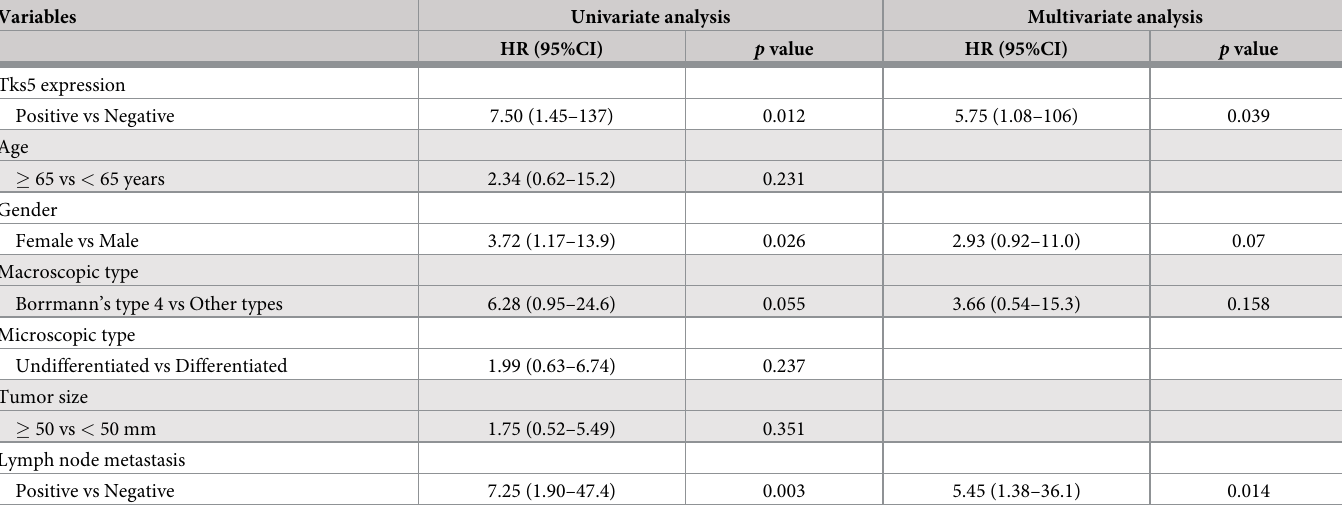
Table 2. Univariate and multivariate analysis for peritoneal recurrence-free survival. Variables Univariate analysis Multivariate